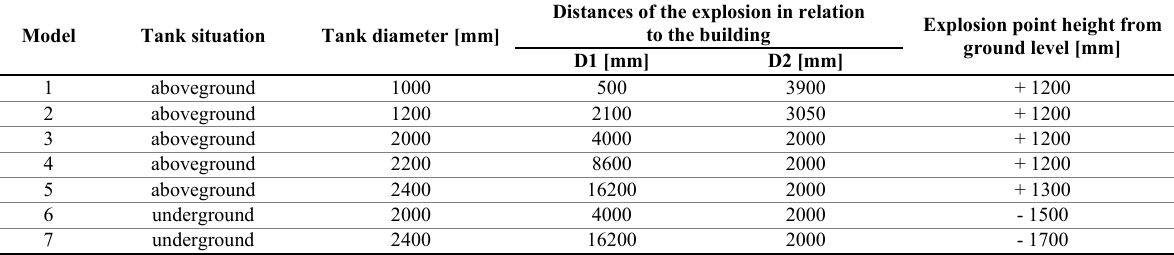
Table 8. Detailing of the tanks in each